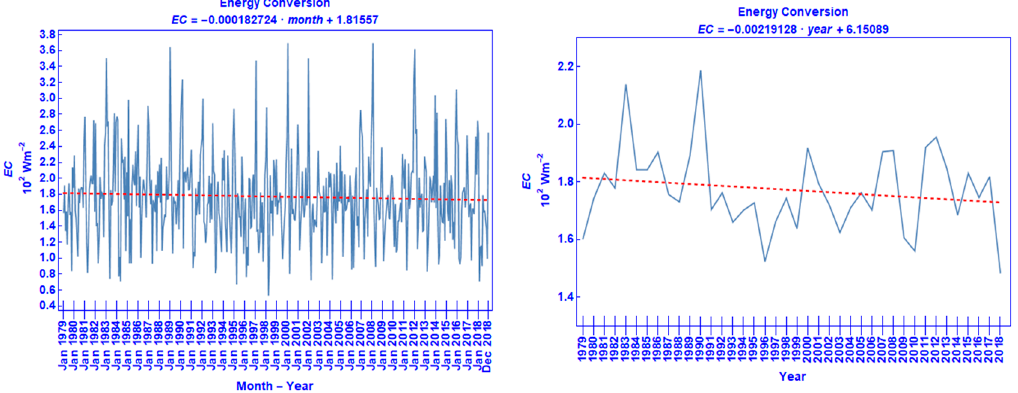
Figure 14. The same as Figure 2, but for EC .